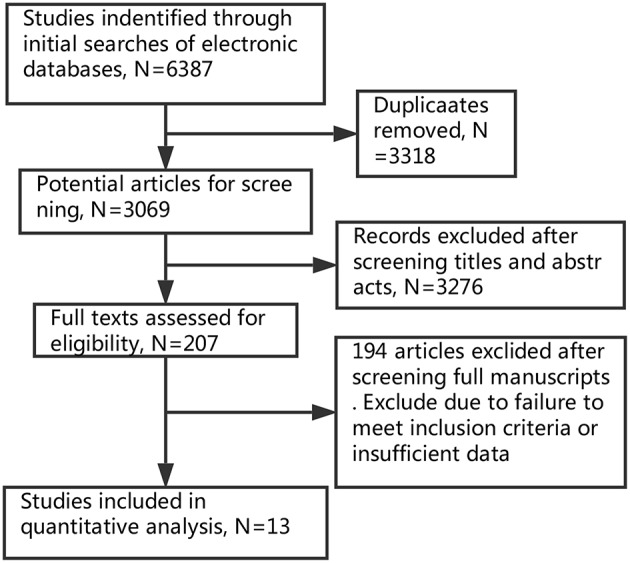
Flow diagram of literature search and study selection.